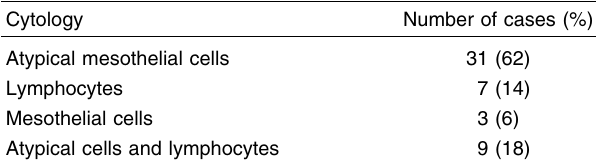
Table 3 Chemical analysis of aspirated pleural effusion Table 4 Cytology of the pleural